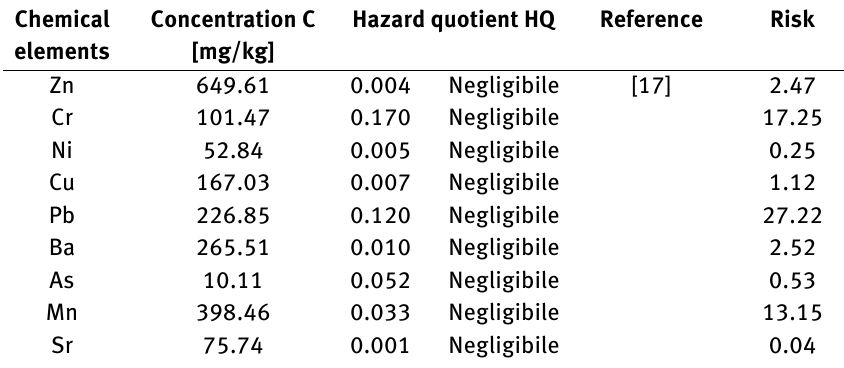
Table 3: Risk related to chemical